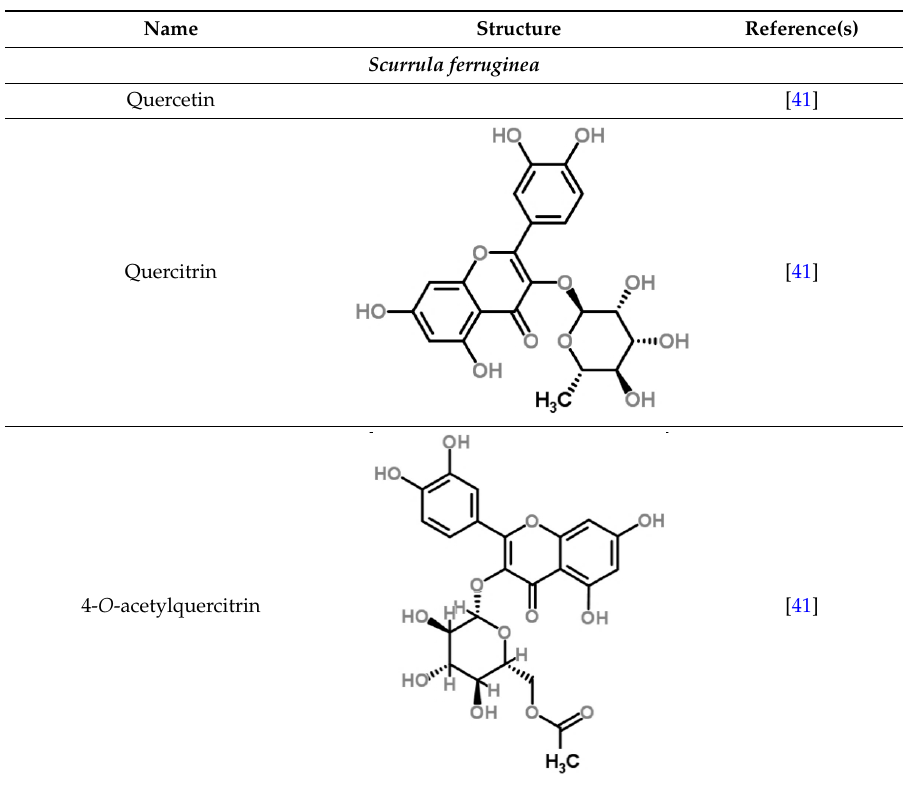
Table 3. Chemical structures of compounds found in Scurrula plants.